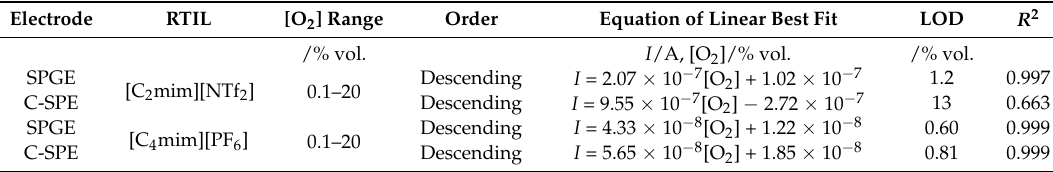
Figure 4. LTCA for different concentrations of oxygen in ( a ) [C 2 mim][NTf 2 ] and ( b ) [C 4 mim][PF 6 ] on a SPGE for 20, 20, 17, 15, 12, 10, 7, 5, 3, 1, 0.5, 0.1, 0.5, 1, 5, 10, 15, 20, and 20% vol. O 2 alternating with periods of N 2 purging. Potentials were held at −0.9 V and −1.2 V, respectively. The inset shows a plot zoomed in at the lowest concentrations (1, 0.5, 0.1, 0.5, and 1% vol. O 2 ). The respective calibration plots for the descending and ascending concentrations are shown on the right. Table 1. Analytical parameters obtained from calibration graphs from LTCA experiments for the reduction of oxygen in the two chosen RTILs, on both the screen-printed graphite electrode (SPGE) and carbon screen-printed electrode (C-SPE) surfaces. Equations of the linear best fit, limits of detection (LODs), and R 2 values of the calibration plots obtained at the low concentration range (0.1–20%, descending) are shown (see Figures 3 and 4). The full set of data from all SPE/RTIL combinations recorded is shown in Table S4 of the Supporting Information.